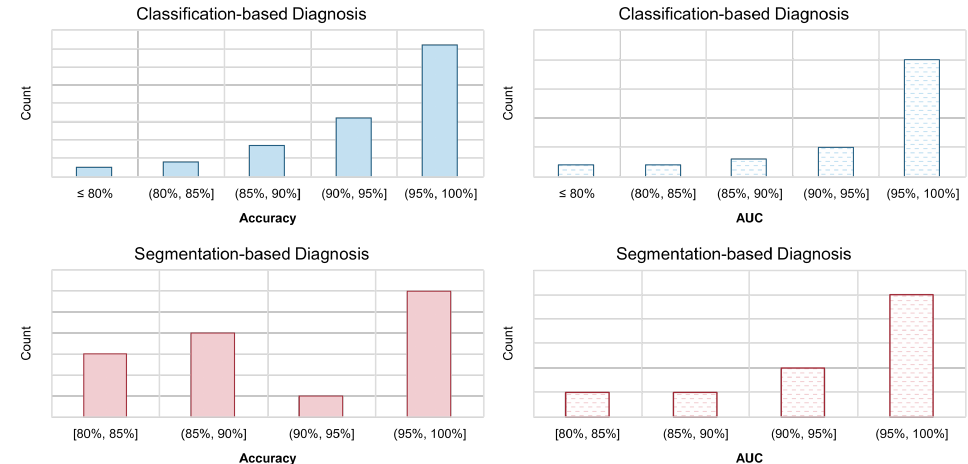
Figure 8. Histograms of the reported performance of automated diagnosis models for COVID-19. We calculate the proportion of the reported model accuracy and AUC metrics that falls within each interval. The model with very high claimed performance (e.g., >95%) accounts for a high